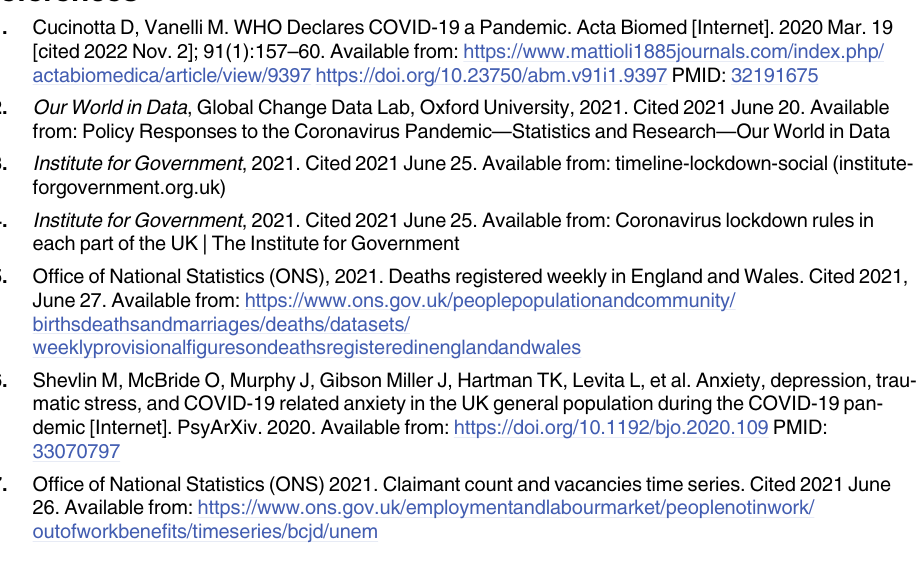
S2 Table. Reported changes: In dietary behaviours, dietary consumption and physical